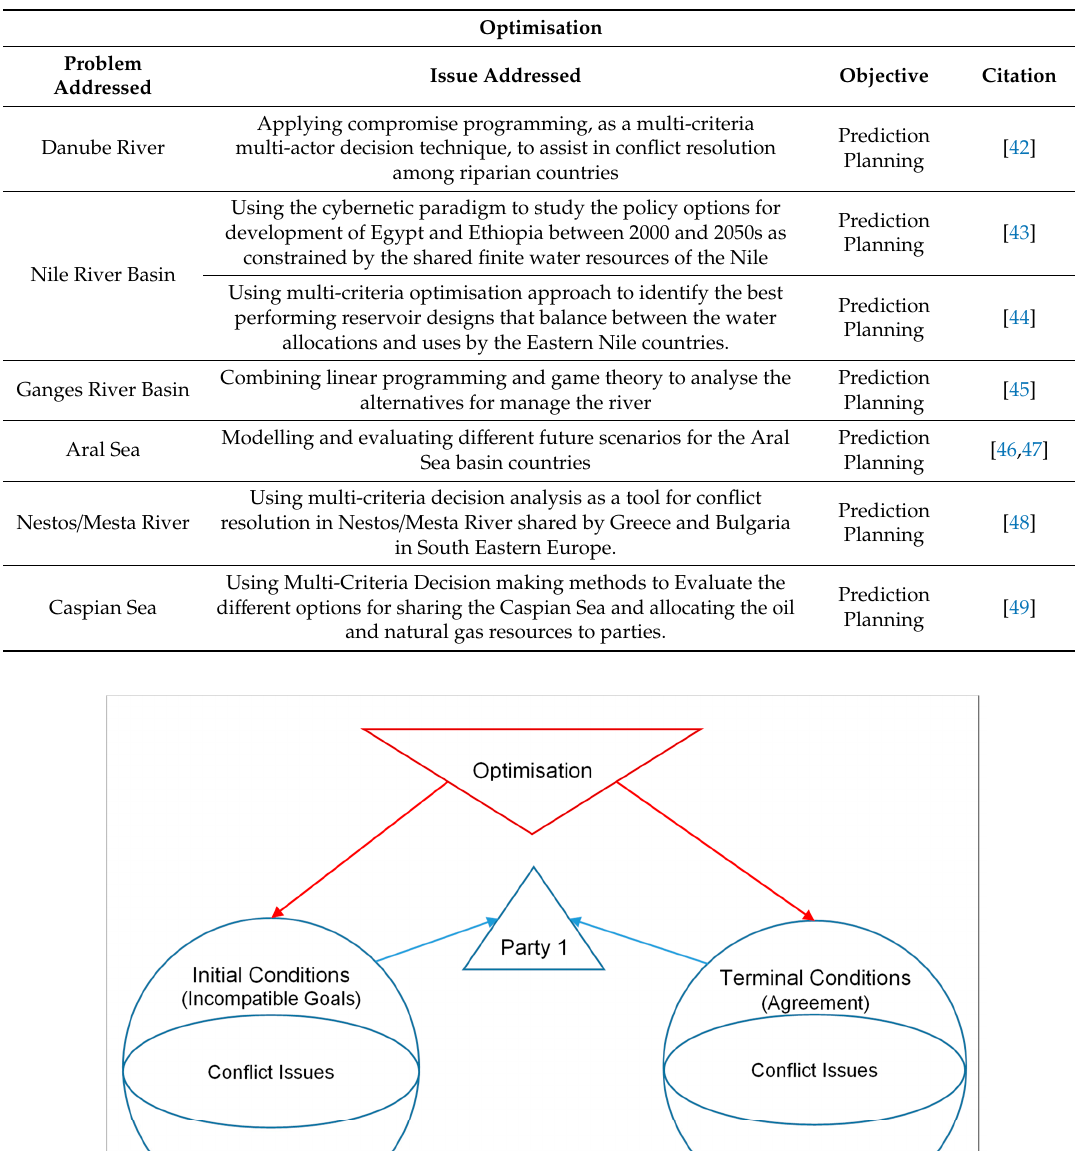
Table 1. Static Models—Theory and Implementation.